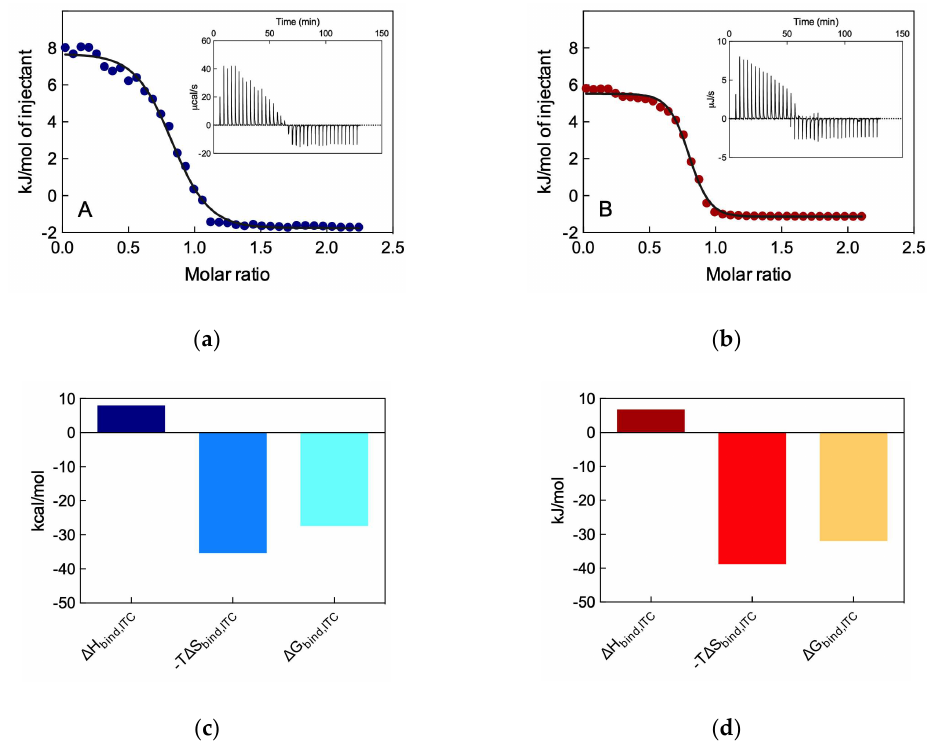
Figure 7. ITC isotherms for self-assembled dendrimers L-G 1 ( a ) and L-G 2 ( b ) heparin binding in buffered solutions at 150 mM NaCl. In both panels, ITC raw data are shown in the inserts while black curves are data fitting. Heparin binding thermodynamic parameters for L-G 1 ( c ) and L-G 2 ( d ), as obtained from the analysis of the corresponding ITC traces shown in panels a and b , respectively. Adapted from [26] with the permission of The Royal Society of Chemistry.